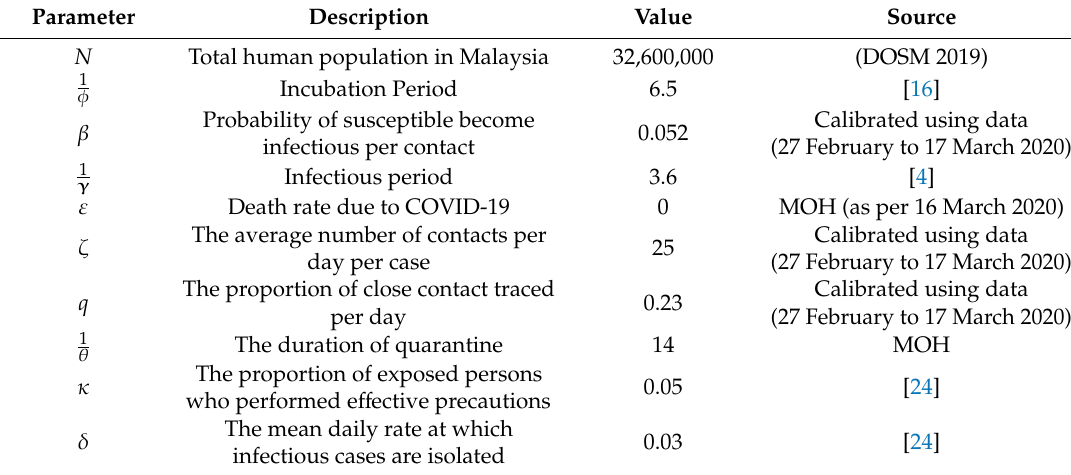
Table 1. Description of the parameters and their corresponding values used in the model simulation. Parameter Description